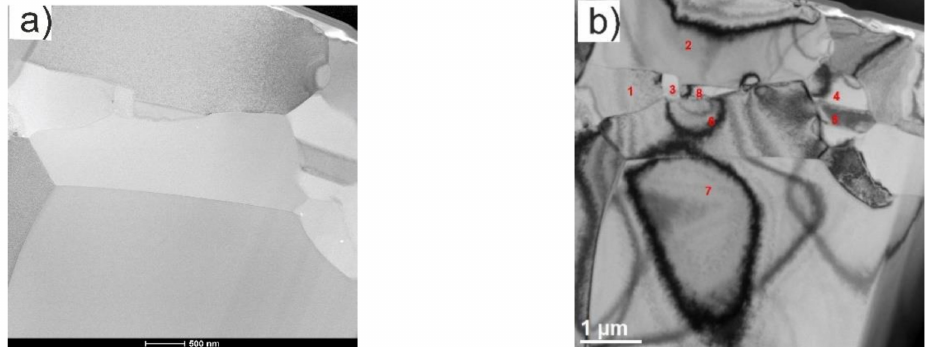
Figure 8. TEM micrographs showing microstructure of the Ti + 20 wt %(Ti,Mo)C composite (the lamella)—surface perpendicular to the direction of composite growth: ( a ) TEM morphology obtained on BF detector; ( b ) TEM micrographs with marked points identified by electron diffraction method; points in the order of numbering from 1 to 8 correspond to the following phases: 1—TiC [031], 2— α -Ti, 3—TiC [211], 4—TiC [100], 5— α -Ti, 6— α ’-Ti [010], 7—TiC [211],8—TiC